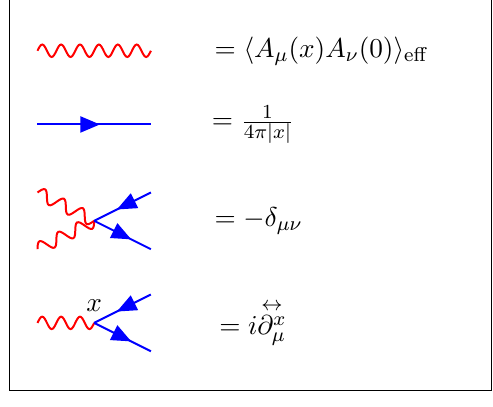
Table 1 . bQED Feynman